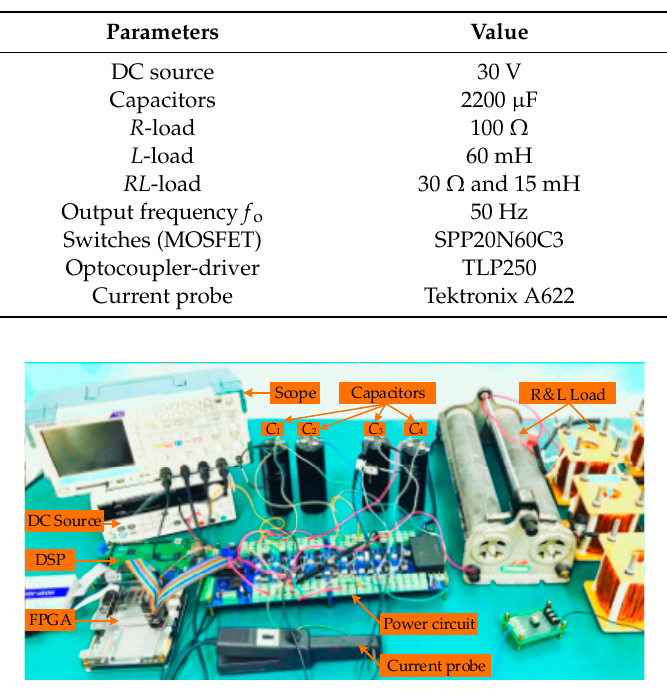
Table 6. Experimental parameters.